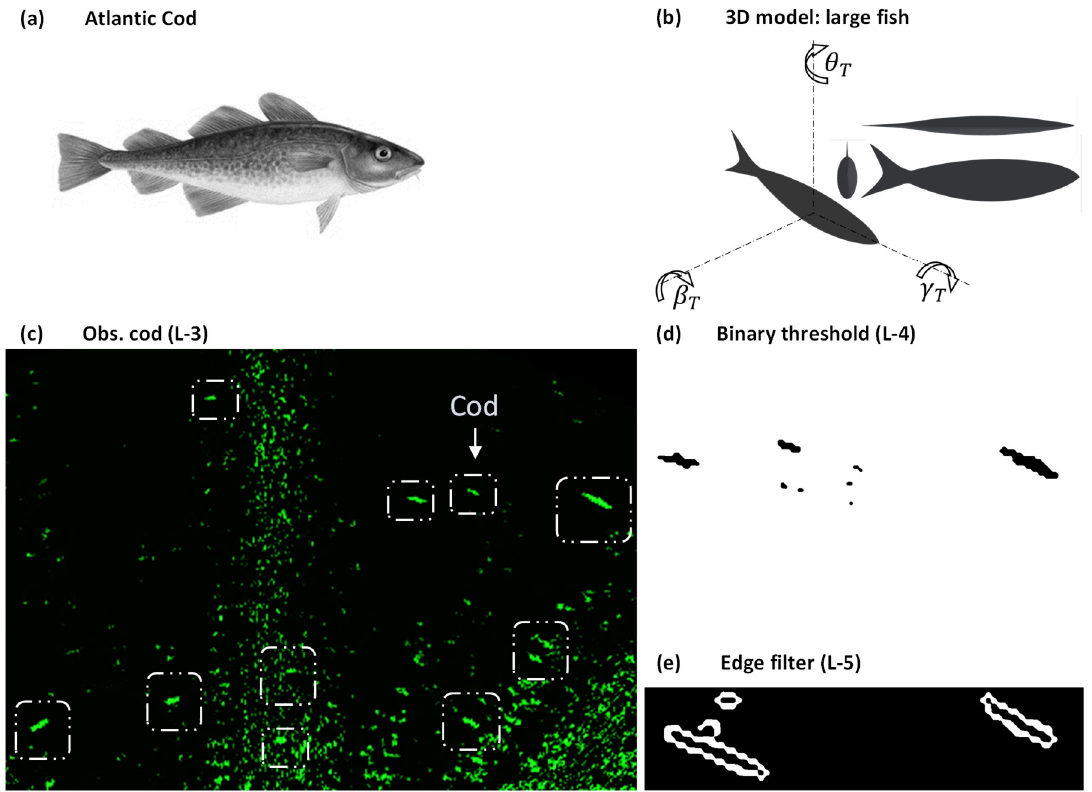
Figure 5. ( a ) Image of cod [36]. ( b ) Three dimensional (3D) model of a cod. ( c ) Acoustic images at level 3 of a cod with 0.7–0.8 m of length, at 10–15 m of range; ( d and e ) Extracted shape and silhouette of a cod from the acoustic image in ( c ) using FIJI with: ( d ) binary threshold and ( e ) edge filter.